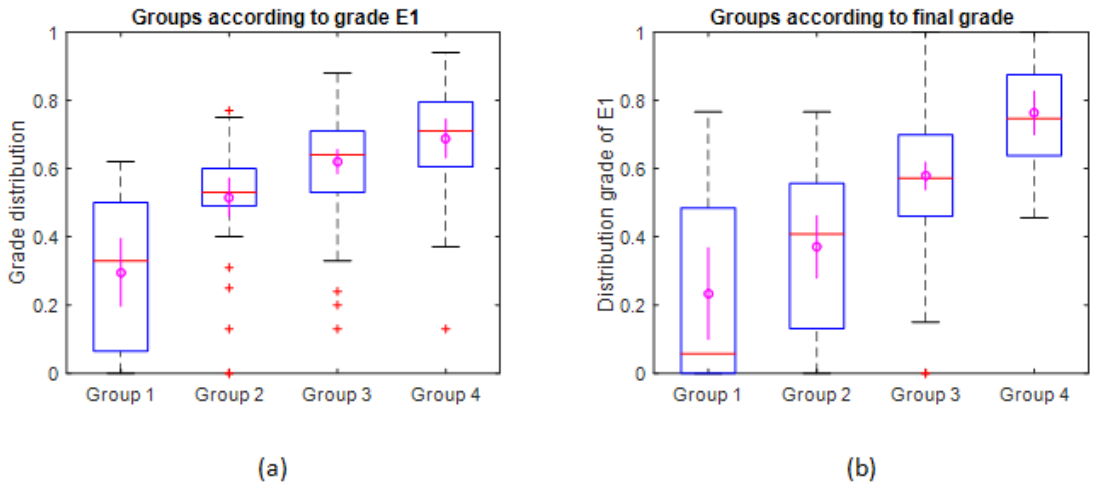
Figure 3. Comparison between E1 and final grade by grouping data